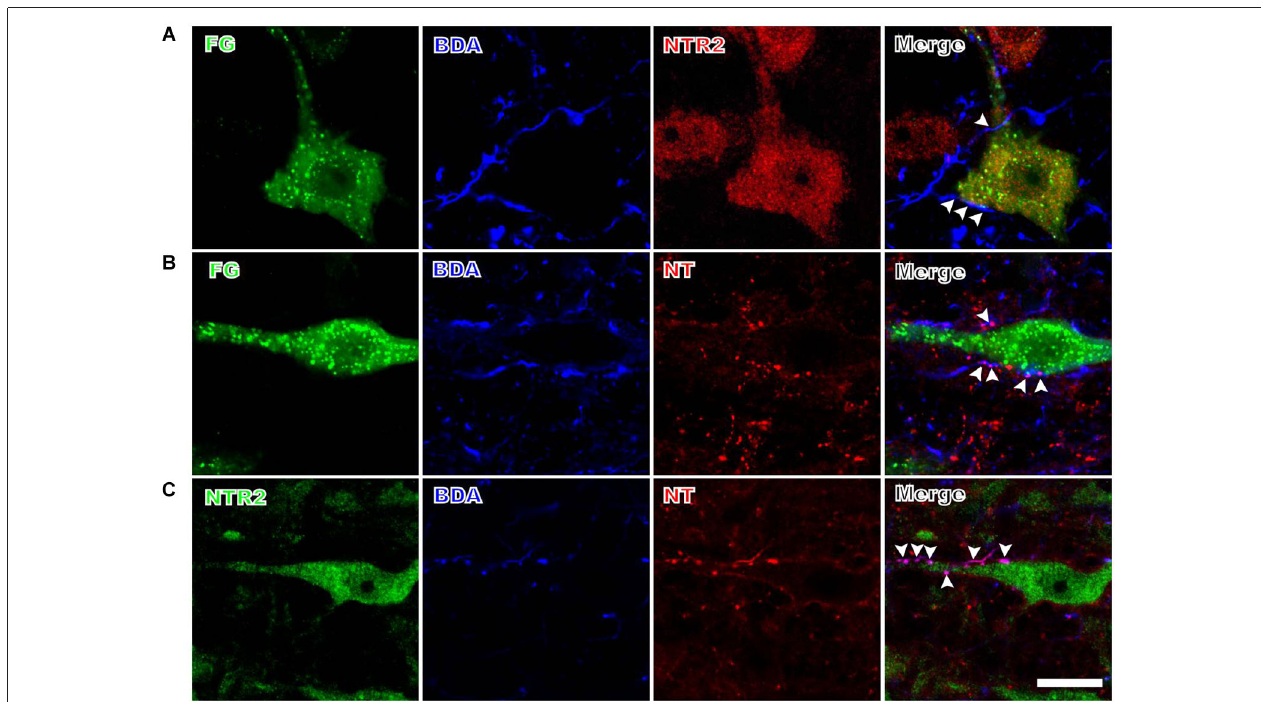
FIGURE 2 | Representative fluorescence photomicrographs displaying the close contacts between anterogradely BDA-labeled fibers and terminals and FG/NTR2 double-labeled neurons (A), between BDA-labeled NTergic fibers and terminals and retrogradely FG-labeled neurons (B), and